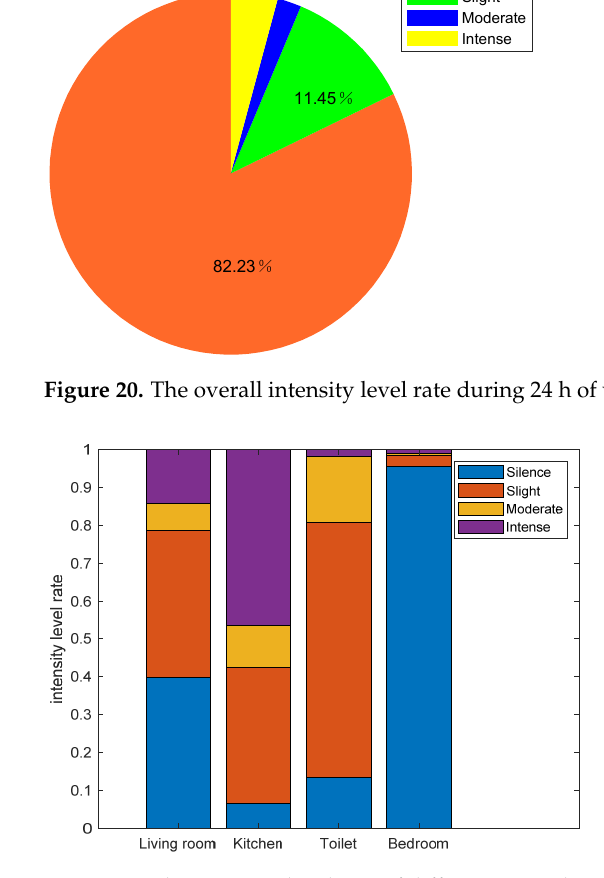
Figure 21. The intensity level rate of different areas during 24 h of volunteer 1.